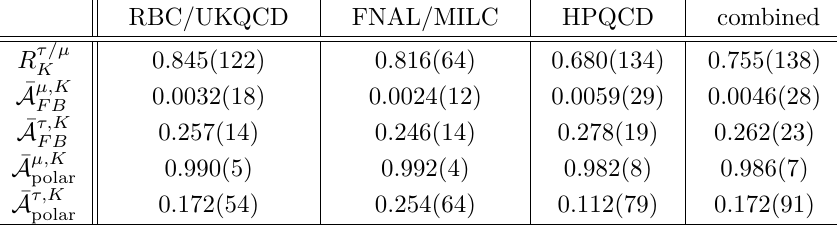
Table 6 . The same as in table 5, but in the case of the semileptonic B s → K decays adopting the RBC/UKQCD, the FNAL/MILC, the HPQCD and the combined LQCD data of table 2 as inputs for our DM